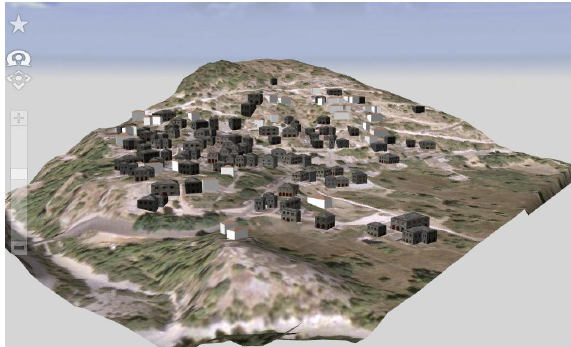
Figure 16. 3D model of the case study area, CityEngine Webscene